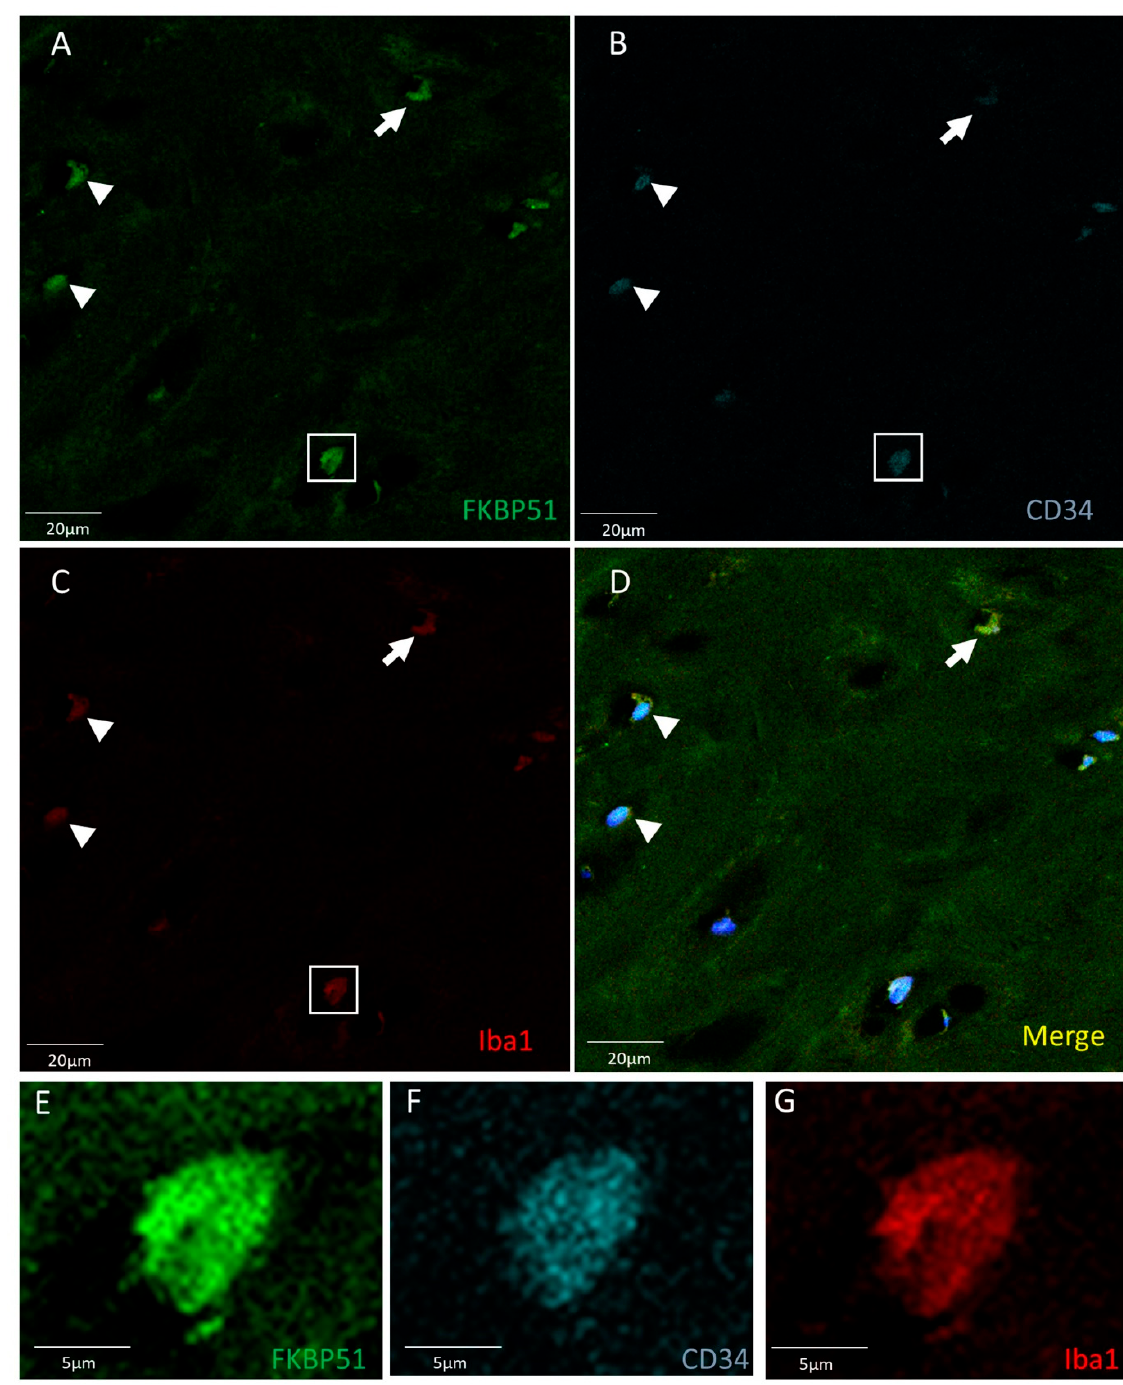
Figure 3. Triple immunolabelling for FKBP51 (green), Iba1 (red), and CD34 (cyan) in tibial plateau cartilage sections from knee OA grade IV, square for higher magnification of a stained chondrocyte ( E – G ). FKBP51+/CD34+/Iba+ cells ( A – D ) at variable staining intensity regarding CD34 labelling, higher intensity (arrowheads and within the square) and lower intensity